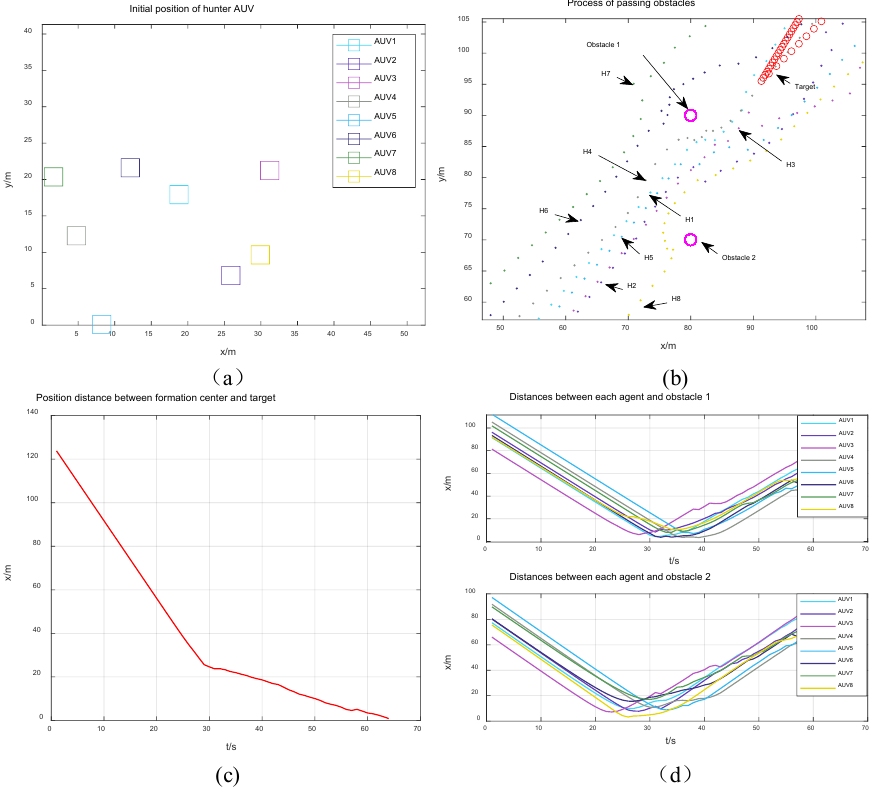
Figure 5. HAP-IAPF method in static environment: ( a ) The initial position of hunter AUV; ( b ) process